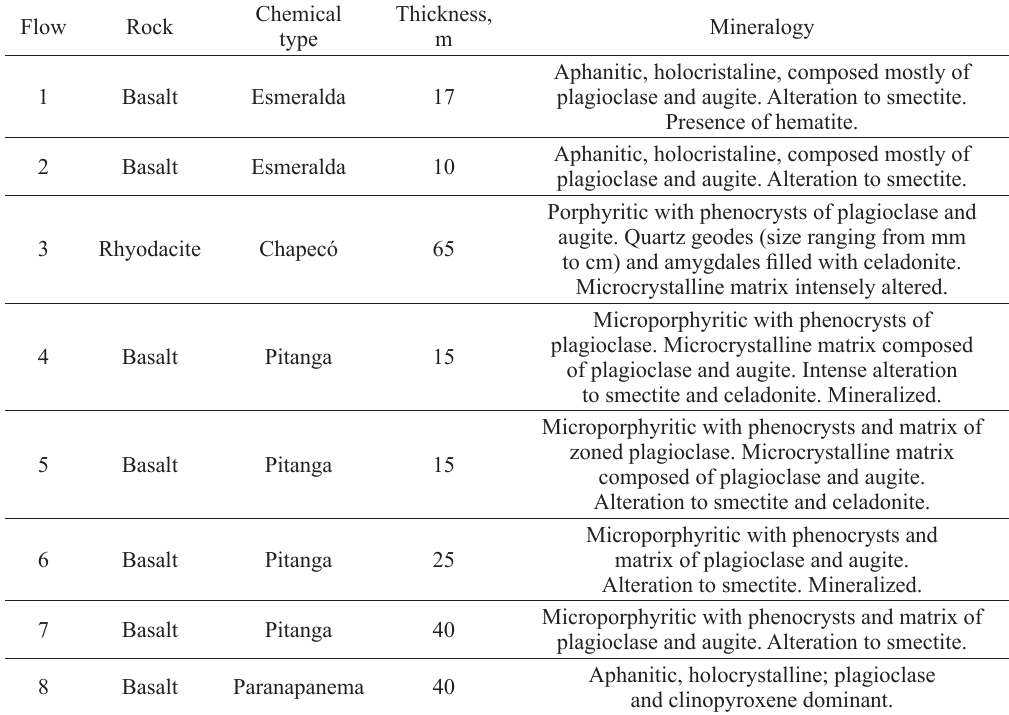
Selected characteristics of the eight lava flows from the Entre Rios district. Flows 5 and 6 are mineralized in